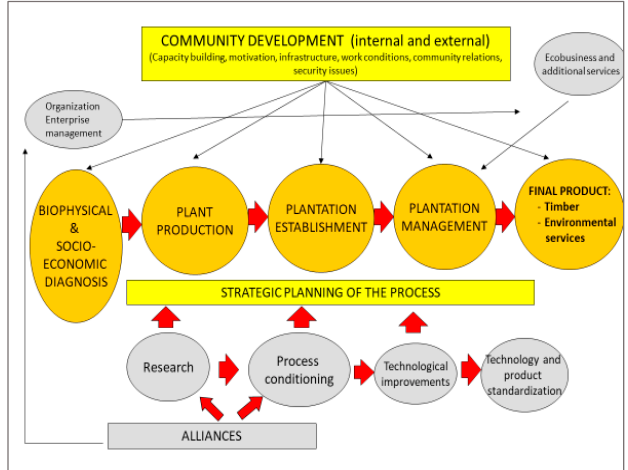
Figure 4. BAM’s management and business.